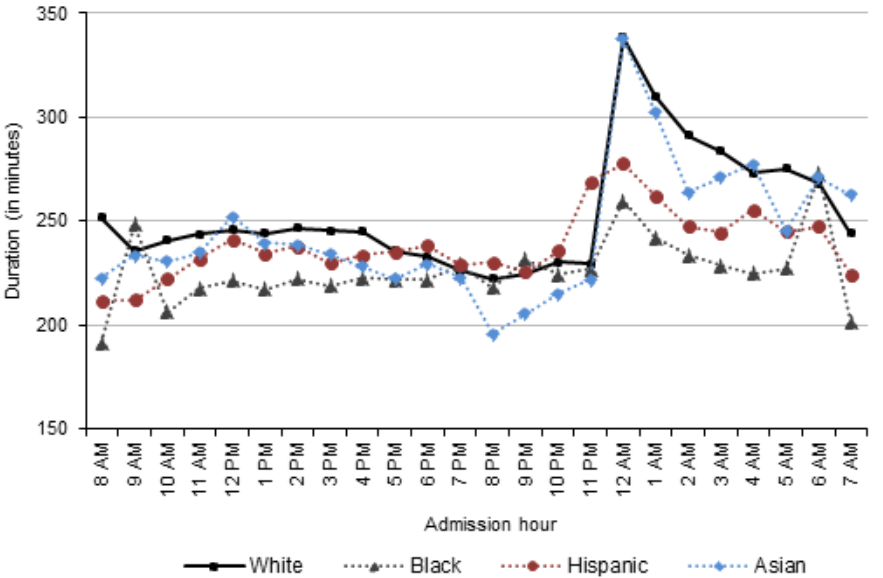
Figure 2. Mean duration of routine visits to the hospital emergency departments of teaching hospitals. Data include all hospital emergency department routine visits that are discharged for home or self care during 2008 in Arizona, Massachusetts, and Utah. Duration is measured in minutes as the difference between admission time and discharge time for each